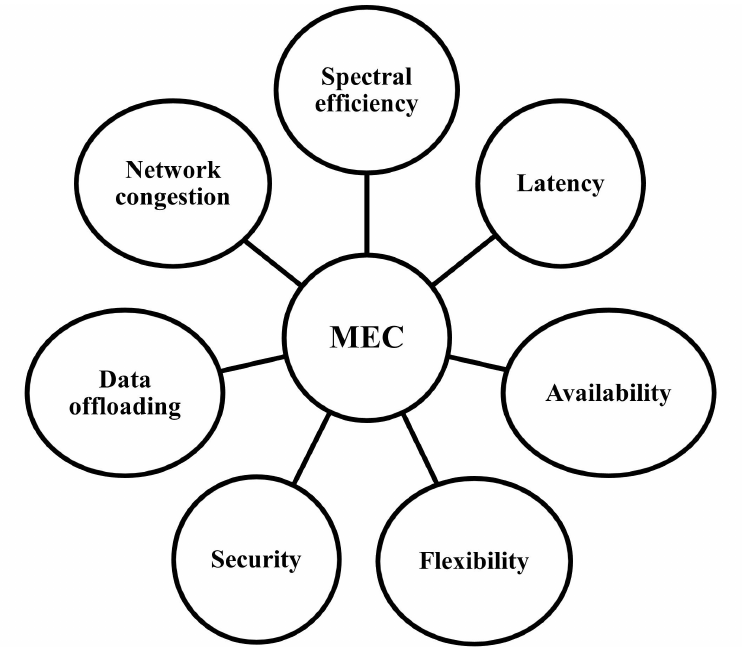
Figure 3. Main benefits of deploying MEC computing for uRLLC